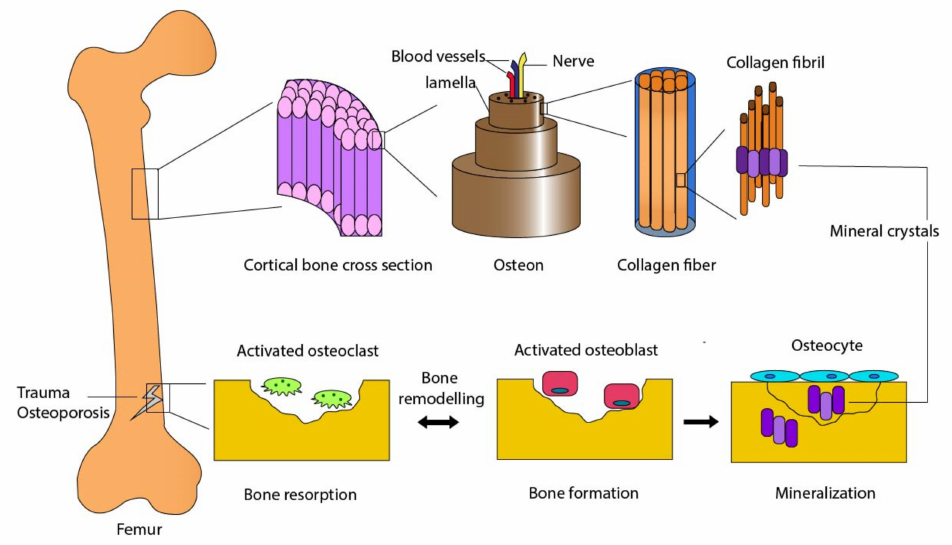
Figure 1. Hierarchical structure and mechanism of the formation and remodeling of long